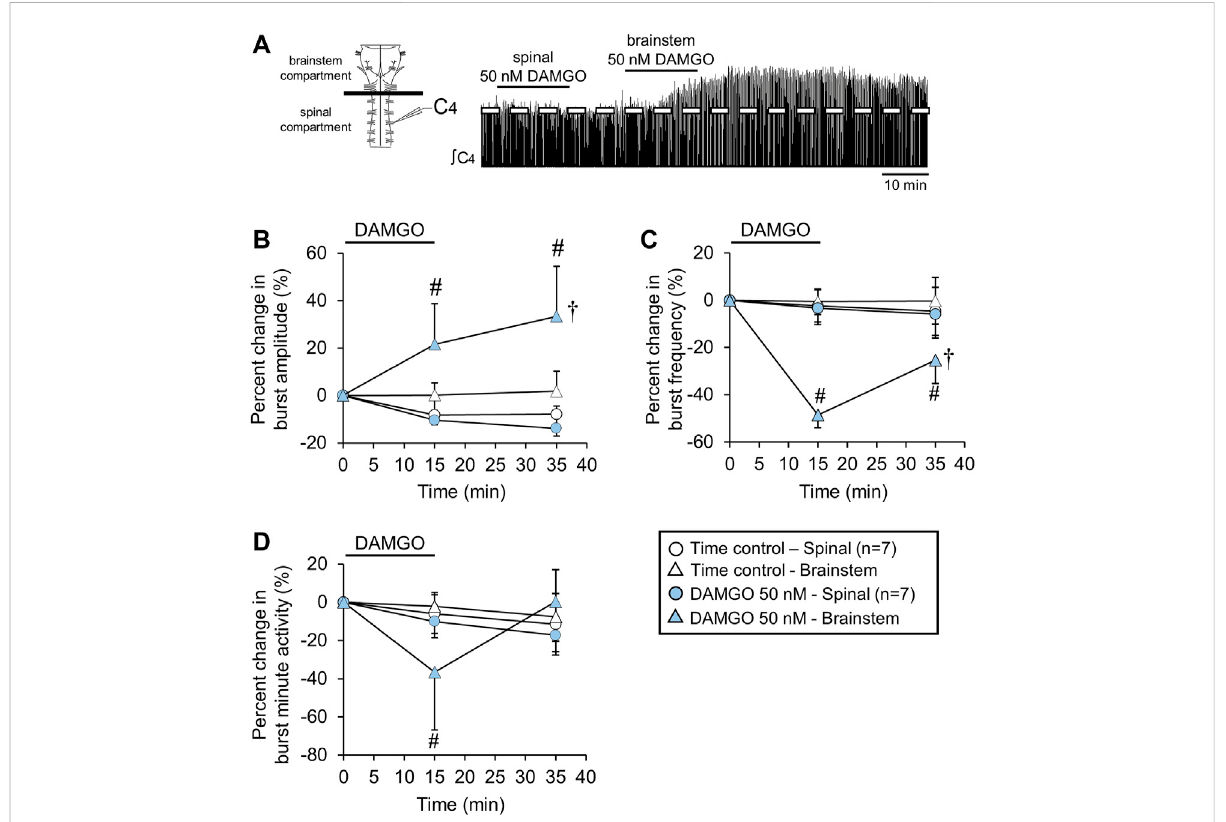
The DAMGO-induced burst amplitude increase was due to brainstem MOR activation. (A) Drawing of brainstem-spinal cord preparation with a plastic and petroleum jelly barrier that separated the recording chamber into separately perfused brainstem and spinal compartments. At right is a voltage trace showing the effects of bath-applied DAMGO (50 nM) in the spinal compartment fi rst, followed by a similar bath-application in the brainstem compartment. (B) The burstamplitude increaseoccurred onlywhen DAMGO wasbath-applied inthe brainstem compartment. Data for time controls and DAMGO application experiments are indicated by the white and blue symbols, respectively (spinal application = circles; brainstem application = triangles). (C) Burst frequency depression was only observed when DAMGO was bath-applied to the brainstem compartment. (D) Minuteactivitydecreasedatthe15-mintimepointwhenDAMGOwasappliedtothebrainstemandnotthespinalcord.Otherwise, there were no overall DAMGO concentration effect of DAMGO on minute activity. The pound sign (#) indicates a signi fi cant pairwise